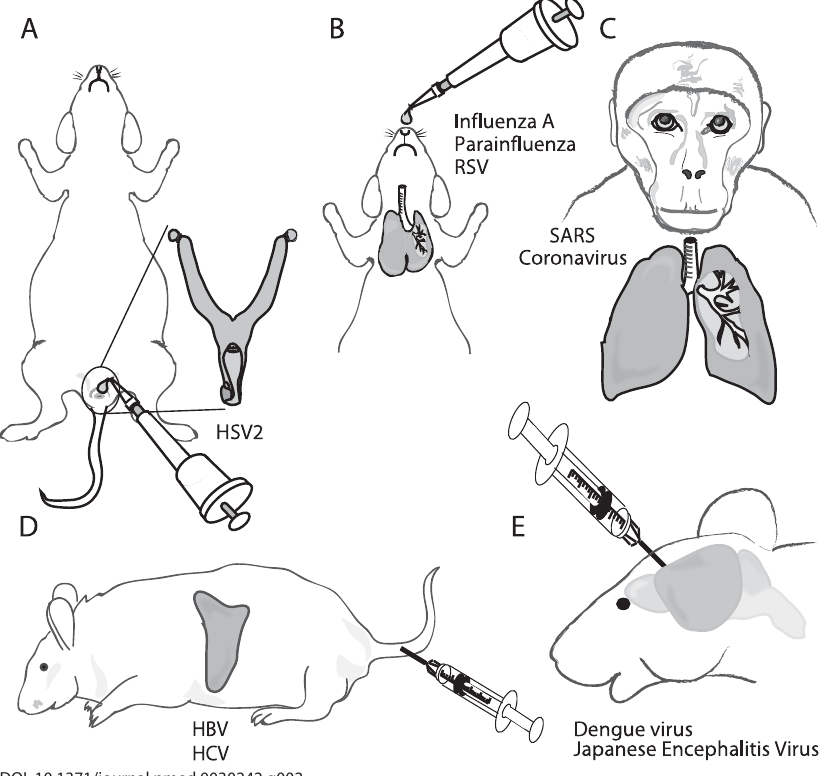
Figure 2. siRNA Antiviral Therapy in Animal